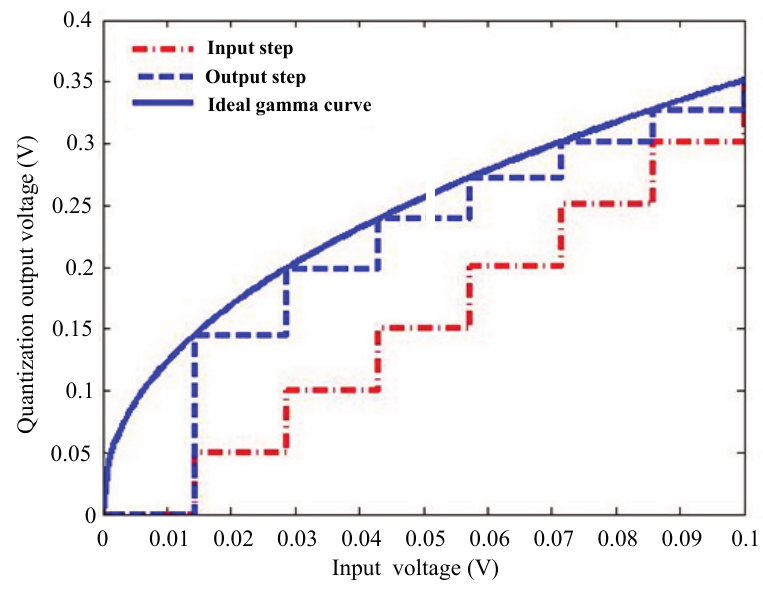
Figure 1. Illustration of gamma correction’s quantization effects in low luminance